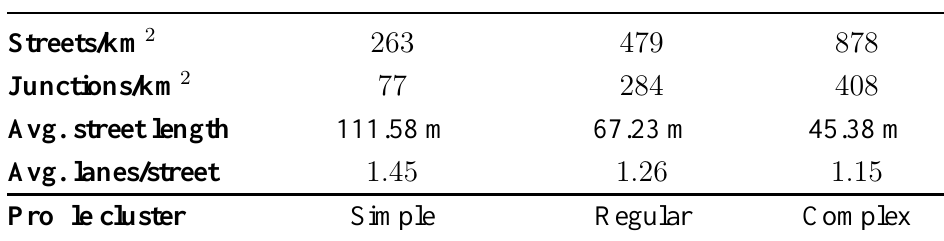
Table 12. Main features of the additional